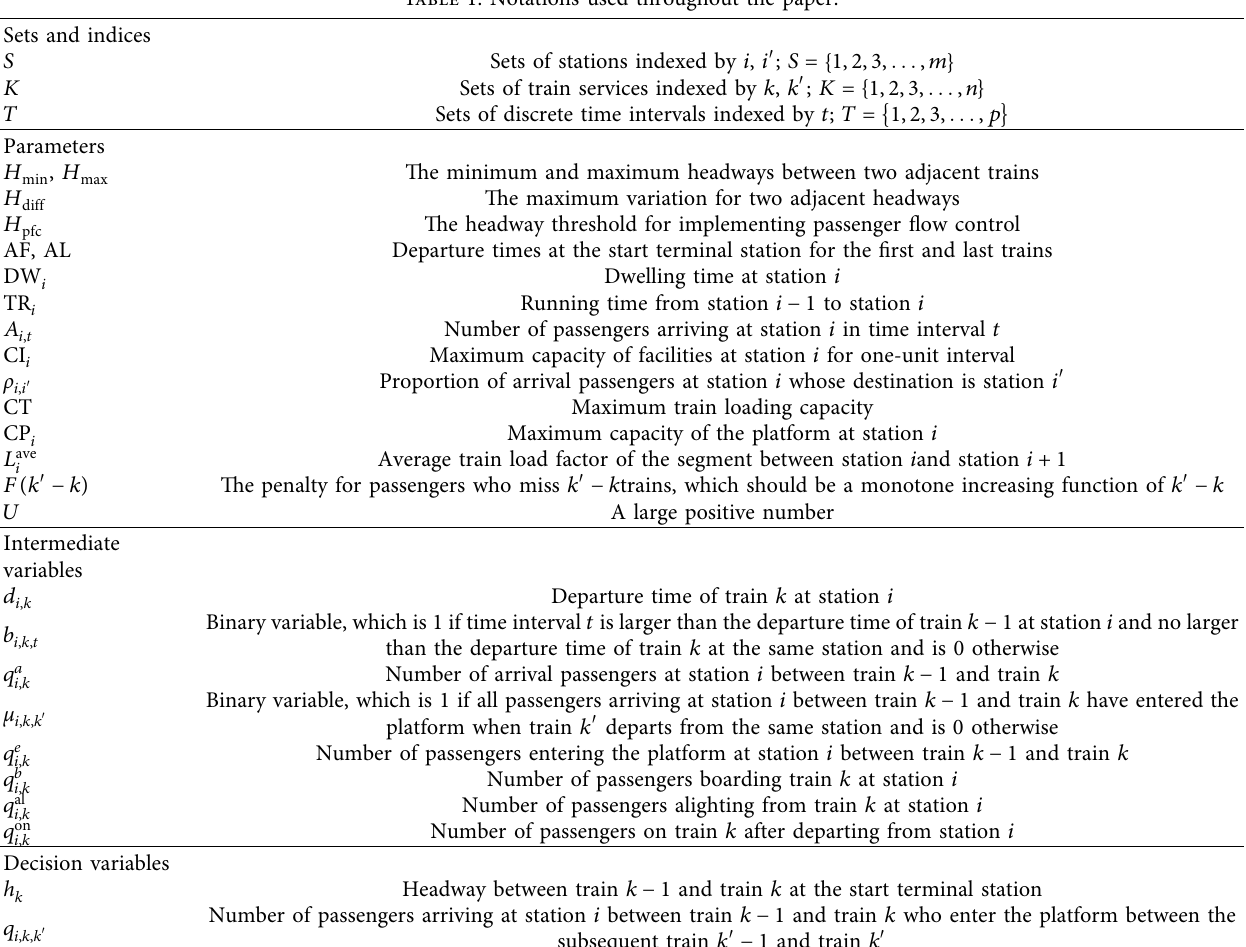
Table 1: Notations used throughout the